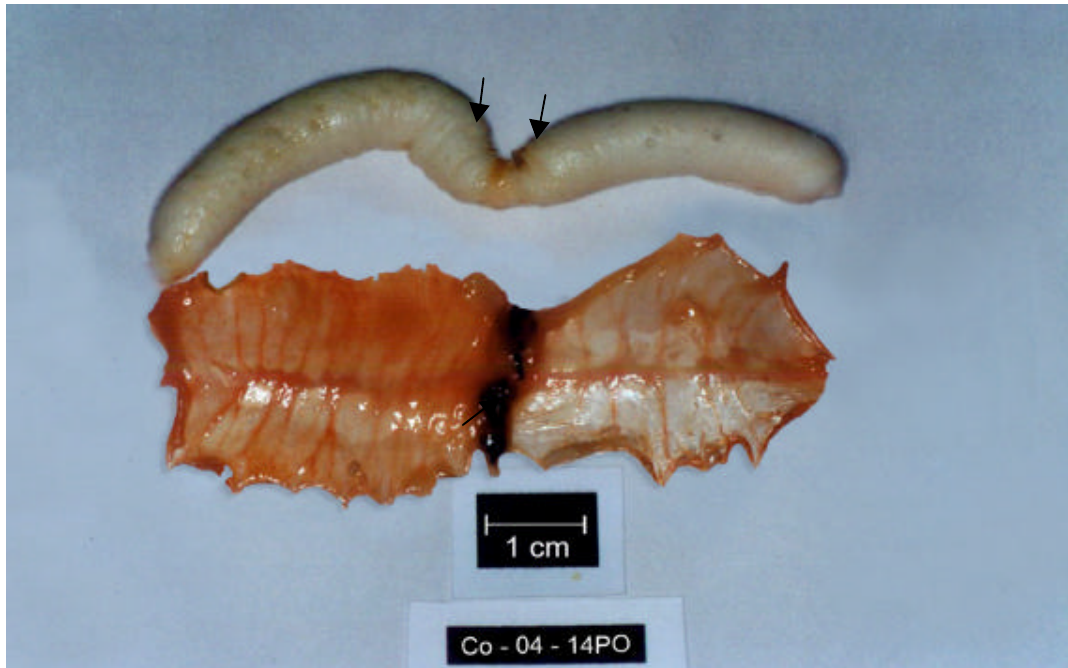
FIGURA 6 – Fotografia da peça operatória da anastomose jejuno-jejunal, mostrando a estenose tanto no molde como na face interna (mucosa) na linha de cicatrização (setas). Sub-grupo Co (adesivo sintético – 6 pontos) no 14º dia de pós-operatório.